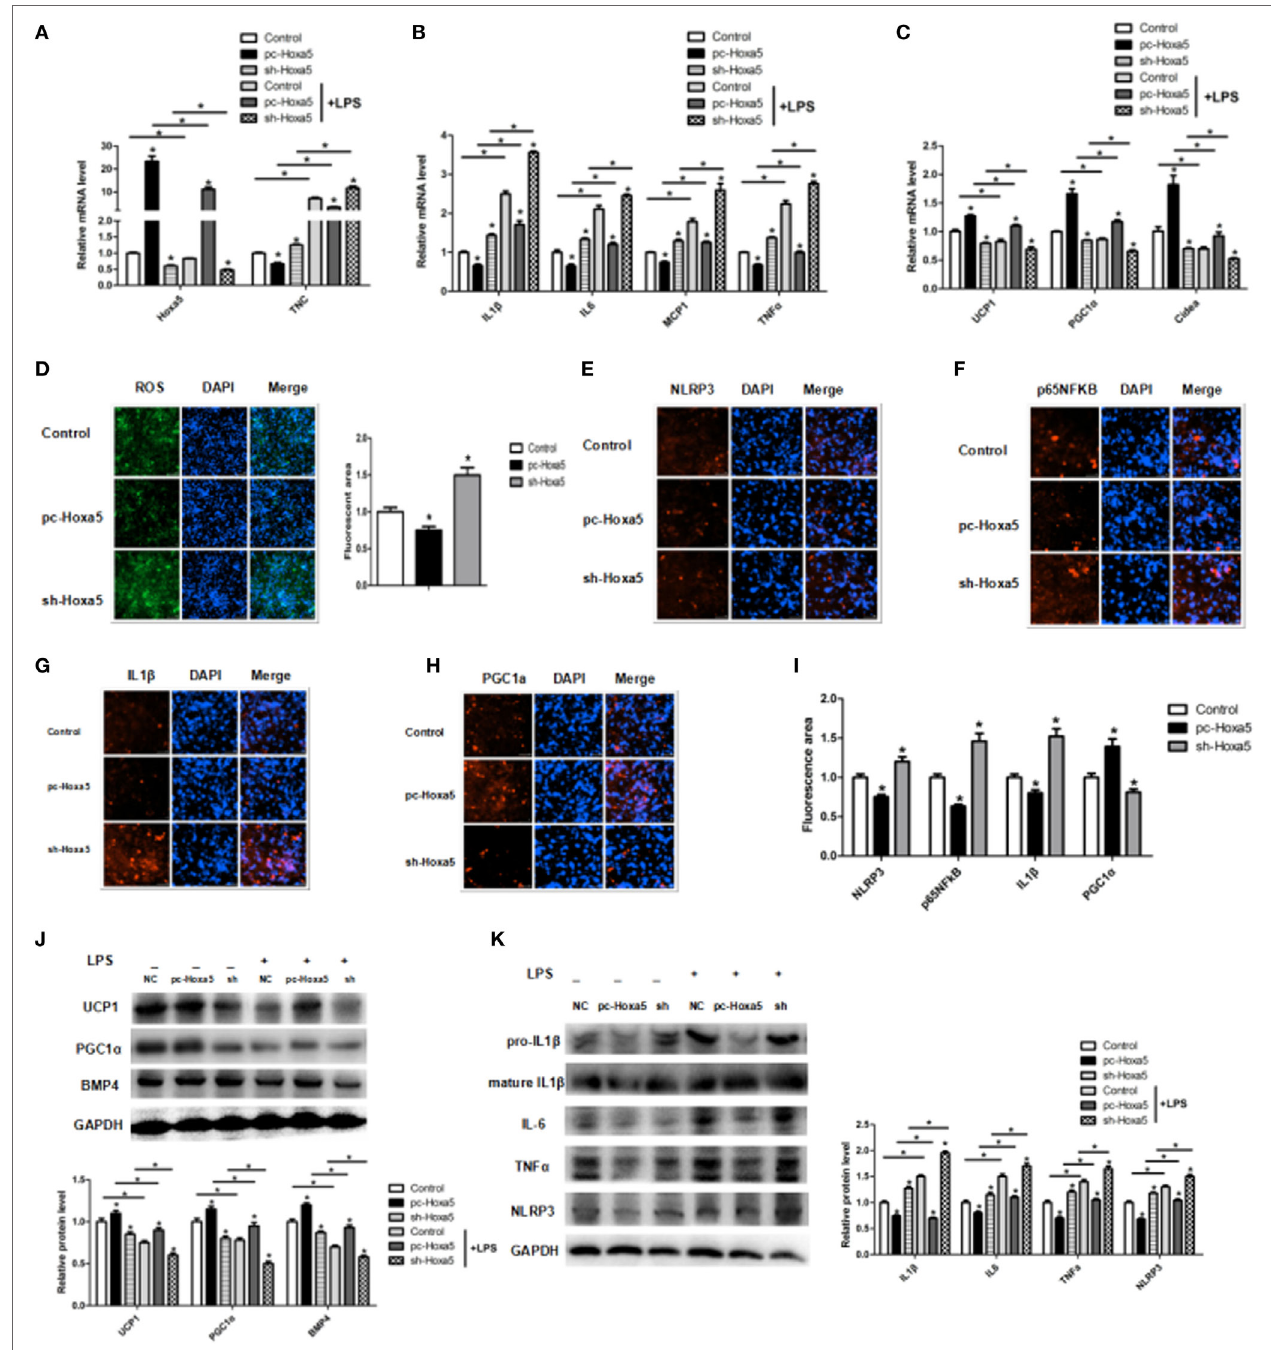
FigUre 4 | Homeobox a5 (Hoxa5) reverses the inhibition of adipocytes browning in lipopolysaccharide (LPS)-treated adipocytes. (a–c) mRNA expressions of Hoxa5, tenascin C (TNC), IL1 β , IL6, MCP1, TNF α and UCP1, PGC1 α , and Cidea in mice adipocytes in the pc-control group, pc-Hoxa5 group, and sh-Hoxa5 group with or without LPS treatment ( n = 4). (D) Fluorescence staining of ROS in different groups with LPS treatment ( n = 4). (e–i) Immunofluorescent staining of adipocytes in different groups with LPS treatment ( n = 4). (J) Immunoblots images of UCP1, PGC1 α , and BMP4 in different groups with LPS treatment ( n = 4). (K) Immunoblots images of IL1 β , IL6, TNF α , and NLRP3 in different groups with LPS treatment ( n = 4). Values are represented as means ± SD vs. control group, * p <